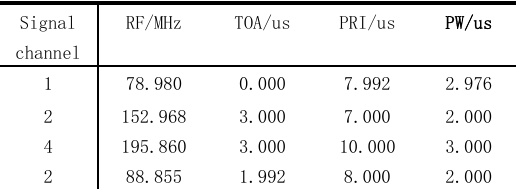
Table 2. Detecting Parameters of four channels’ different signal by